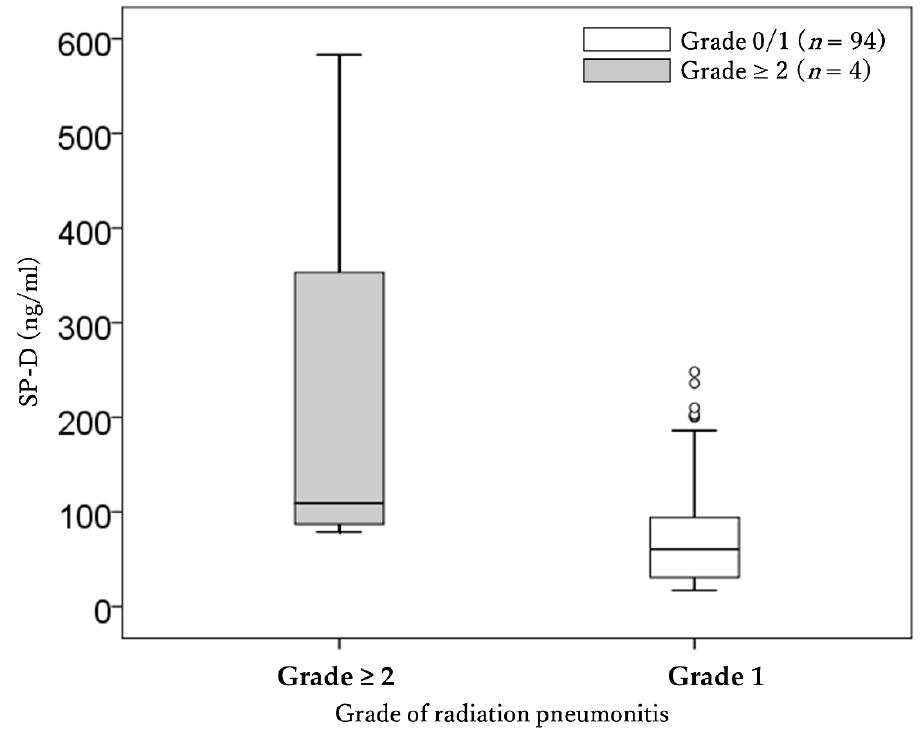
Figure 4. Comparison of pretreatment SP-D between patients with grade 0–1 and grade 2–3 radia-